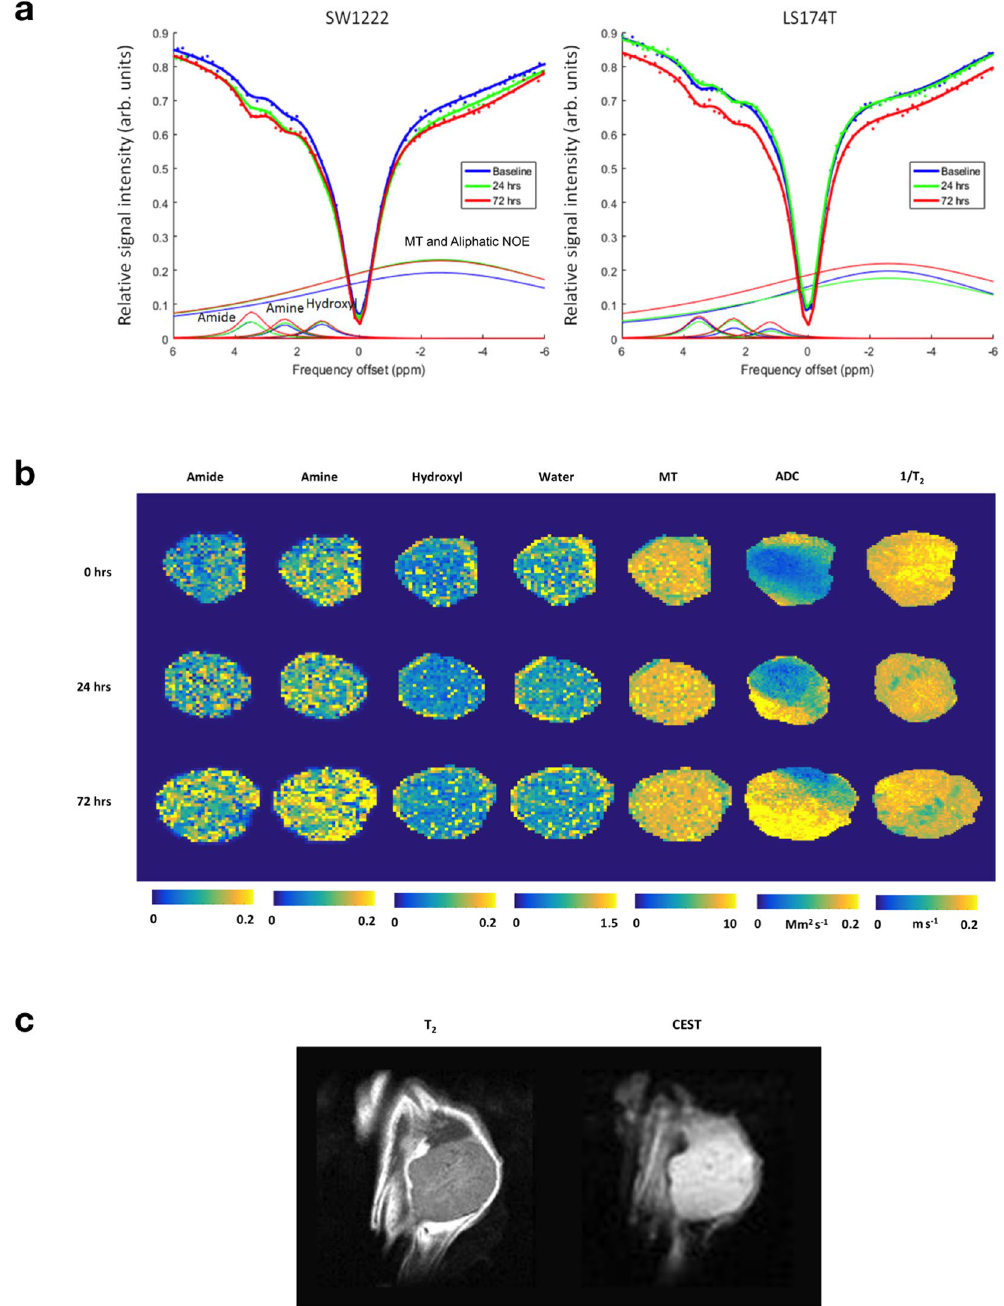
Figure 3. Example MRI measurements in SW1222 and LS174T tumors, prior to and at 24 and 72 hours following treatment with Ixazomib, showing increasing amide and amine peak areas, alongside increasing apparent diffusion coefficient (ADC). ( a ) Z-spectra from CEST MRI, showing the normalised MRI signal intensity as a function of saturation frequency offset, averaged over a single representative tumor dataset at baseline and 24 and 72 hours following dosing with 11 mg kg − 1 of Ixazomib. Data points were fitted to a Bayesian model that allowed the individual influence of proton exchange between water and amide, amine and hydroxyl groups to be isolated (1.2, 2.4 and 3.5 ppm, respectively), alongside the combined effect of magnetisation transfer (MT, − 2.4 ppm) and nuclear Overhauser effect (NOE, − 3.3 ppm). Water peaks (0 ppm) have been removed for clarity. ( b ) Images of amide, amine hydroxyl, MT and water peak areas, acquired noninvasively in an example SW1222 tumor at baseline and post-therapy (24 and 72 hours). Maps of the apparent diffusion coefficient (ADC) from diffusion MRI measurements and the transverse relaxation time (T 2 ) are also shown. ( c ) Representative T 2 -weighted (left) and CEST reference images